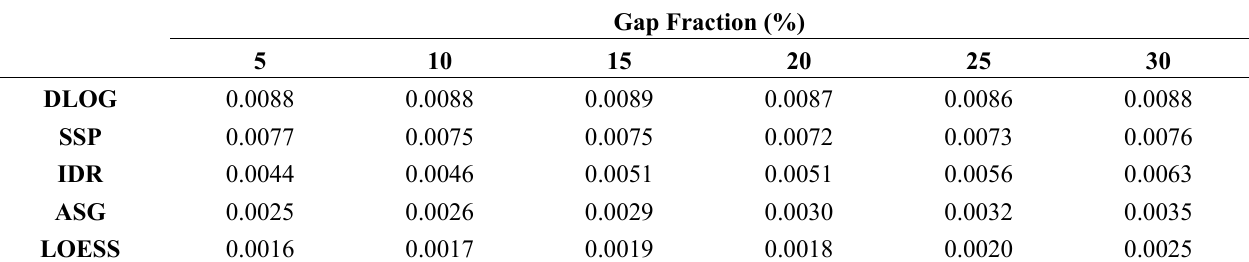
Table 4. Average MAE (nine selected sites) with noise parameters of N ( μ = − 0.025, σ = 0.025) and considering varying gap fractions. Gap Fraction